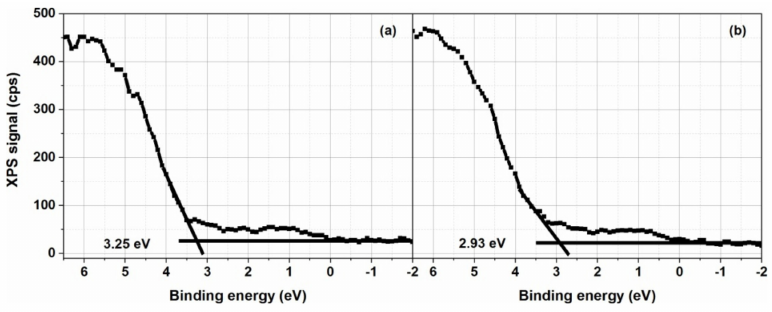
Figure 5. VB-XPS spectra of: ( a ) reference sample, ( b ) TZN_30